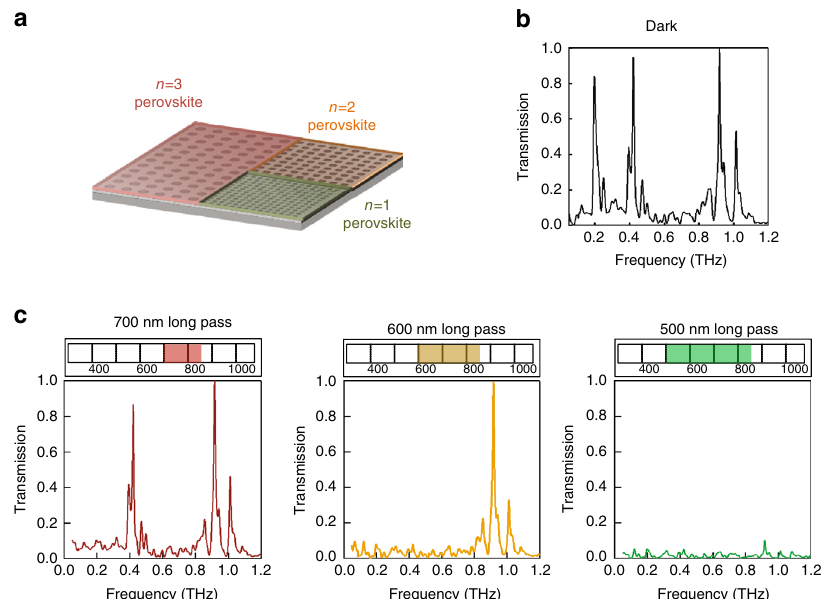
Fig. 5 Excitation selective THz modulator. a Schematic of a resonant device that consists of three different aperture array sections coated with different 2D perovskite layers as denoted. b The THz spectrum of the device in the dark showing the resonant response for all three sections. The lowest order resonances for each section have peaks at 0.22 THz, 0.41 THz, and 0.95 THz, respectively, that correspond directly to the aperture spacing in each section. The smaller bands next to the primary bands correspond to higher order plasmonic resonances. c (left to right) THz spectra of the device illuminated with 700 nm long pass fi lter, 600 nm long pass fi lter, and 500 nm long pass fi lter, respectively. The optical excitation range is shown above each spectrum. For example, a 600nm long pass fi lter allows for illumination from 600 to 850 nm. Thus, a broader optical spectrum can span multiple exciton excitation ranges. The entire device was uniformly illuminated in each